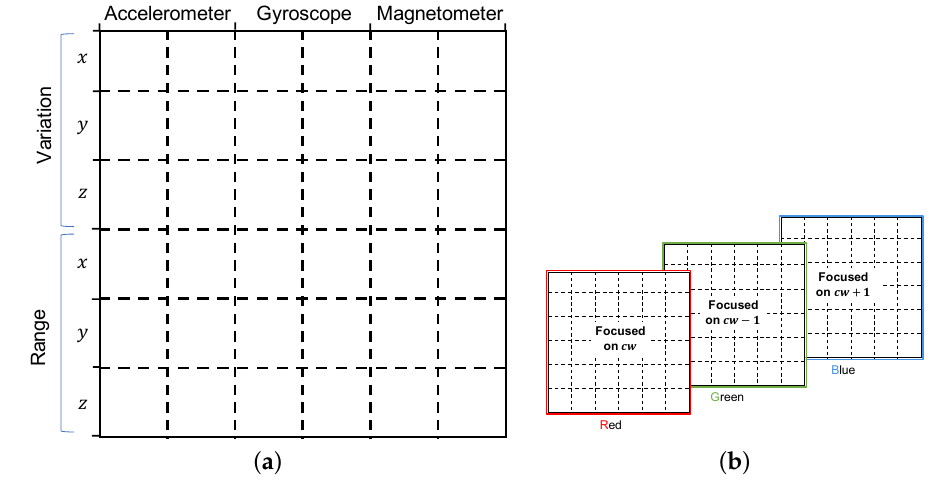
Figure 7. Image representation—Design-A. ( a ) Single channel and ( b )